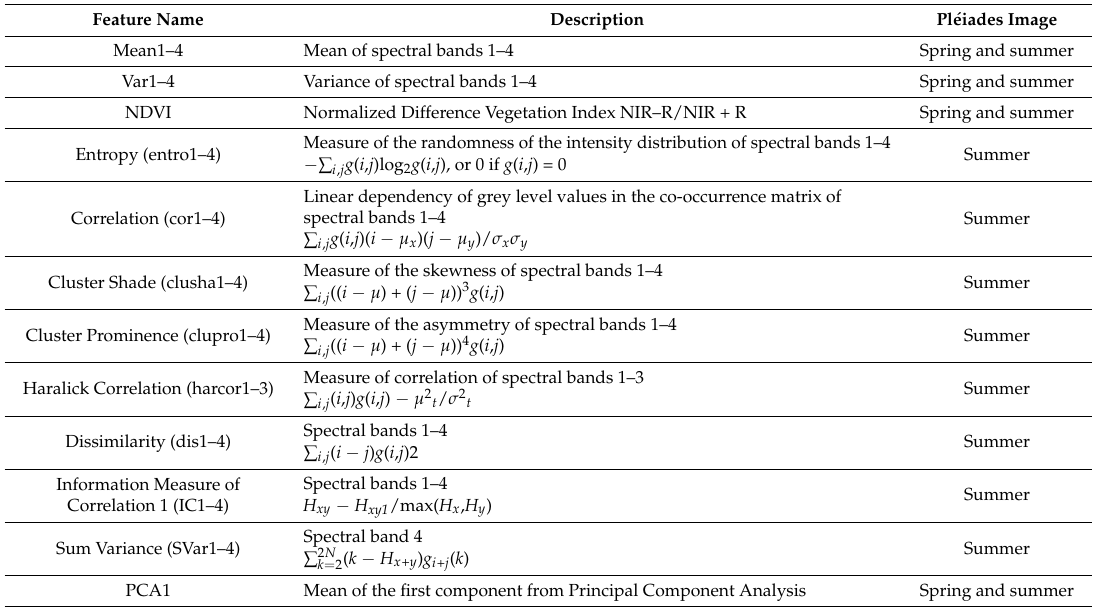
Table 3. Description of features extracted from spring and summer Pl é iades images and used for the